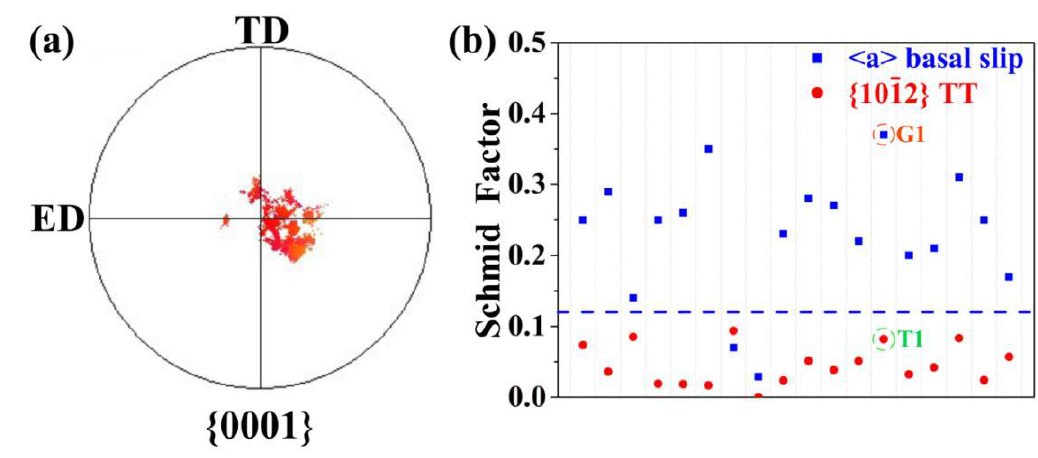
Figure 8. ( a ) {0001} pole figure of the parent grains containing activated {10 − 12} tension twins in the RT-0.08 sample; ( b ) Schmid factors of basal slip and {10 − 12} tension twinning in RT-0.08 sample.